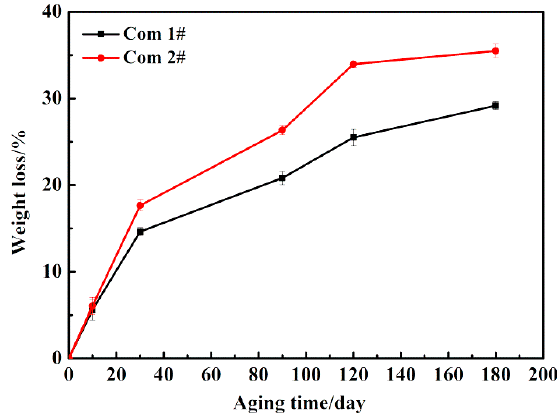
Figure 5. Weight loss of the Com 1# and Com 2# vs. aging time.